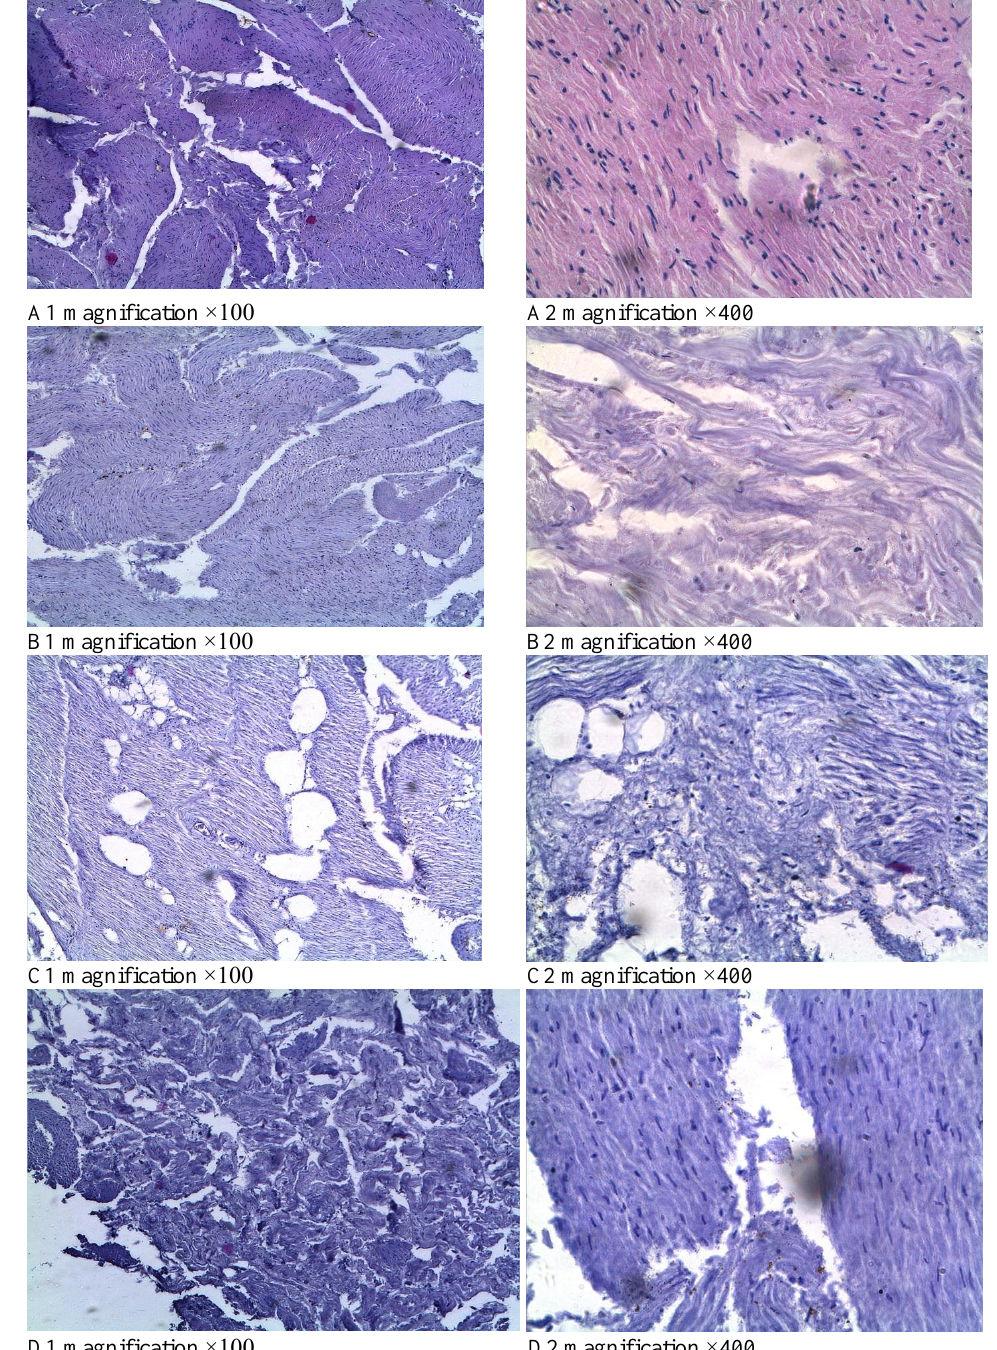
Figure 1. Microstructure of fermented hen gizzards (hematoxylin-eosin staining). ( A1 , A2 ) control sample in the start time; ( B1 , B2 ) fermented control sample; ( C1 , C2 ) fermented test sample with BLC; ( D1 , D2 ) fermented test sample with Propionix